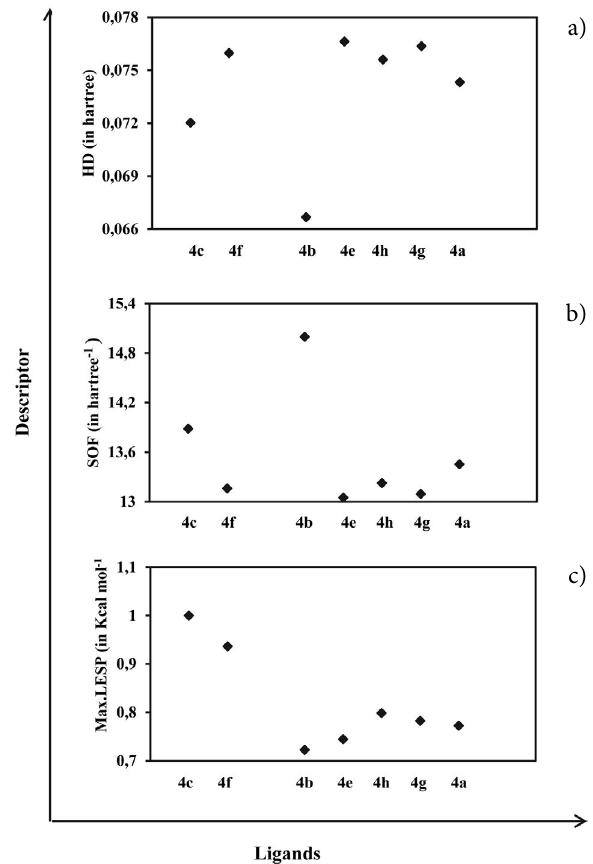
Figure 7. Comparison of HD (a), SOF (b) and Max.LESP (c) of all ligands, except 4d , with them values of the highly active ligand 4b